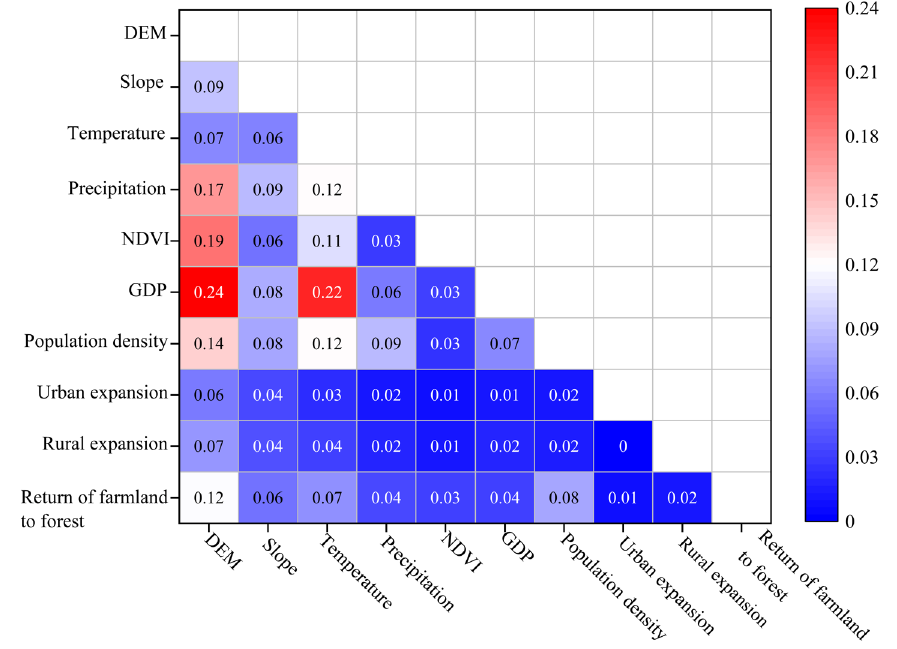
Figure 5. Results of the correlation analysis of interacting factors.